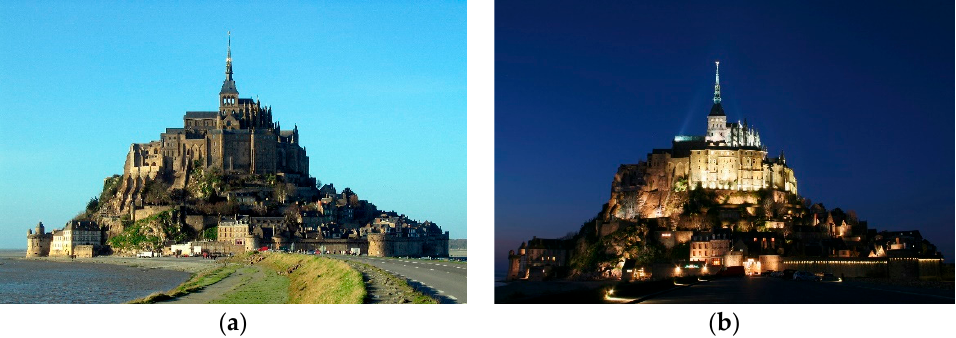
Figure 1. ( a ) Mont Saint Michel, France, day image. (Credits: Wikipedia—Luca Deboli—originally posted to Flickr as Lun de Miel 443, CC BY 2.0). ( b ) Mont Saint Michel, France, night image. Lighting project: Light Cibles, Louis et Emmanuel Clair, 2006. (Credits: Wikipedia—Benh Lieu Song—own work, CC BY 2.5).